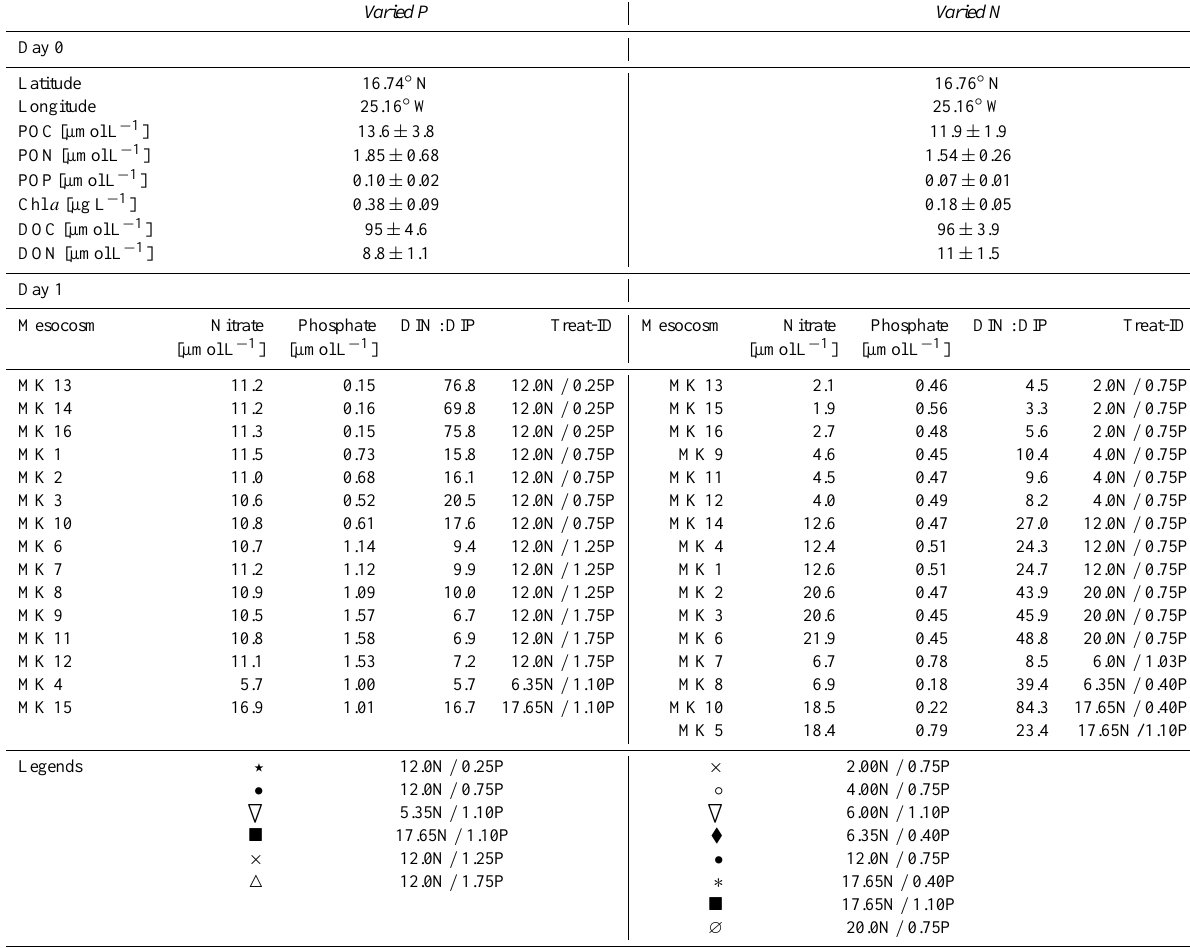
Table 1. Summary of initial conditions of the seawater used to fill the mesocosms during the two experiments, target nutrient concentrations (Treat-ID), and different nutrient conditions inside the mesocosms after nutrient addition (day 1). Varied P Varied N Day